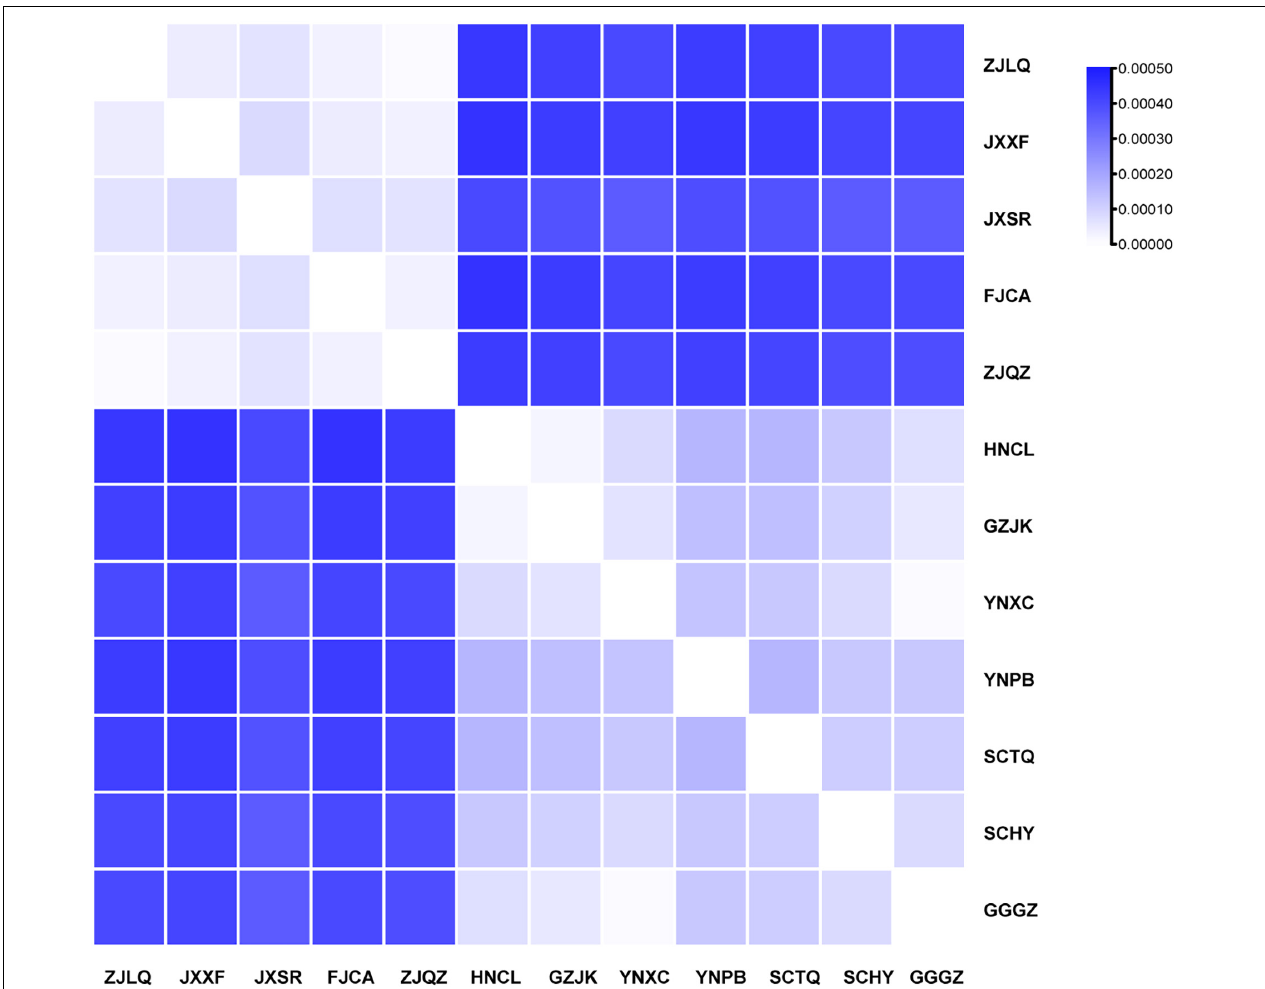
FIGURE 6 | Pairwise genetic distances between B. sinensis samples.